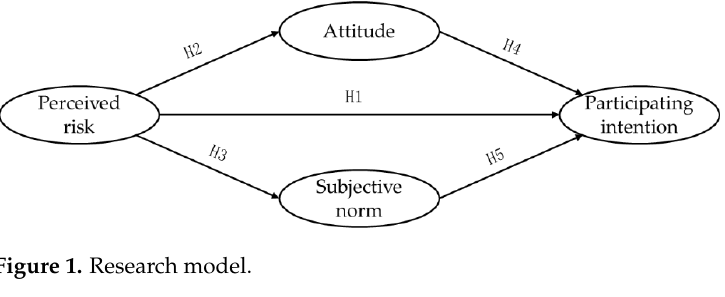
Figure 1. Research model.